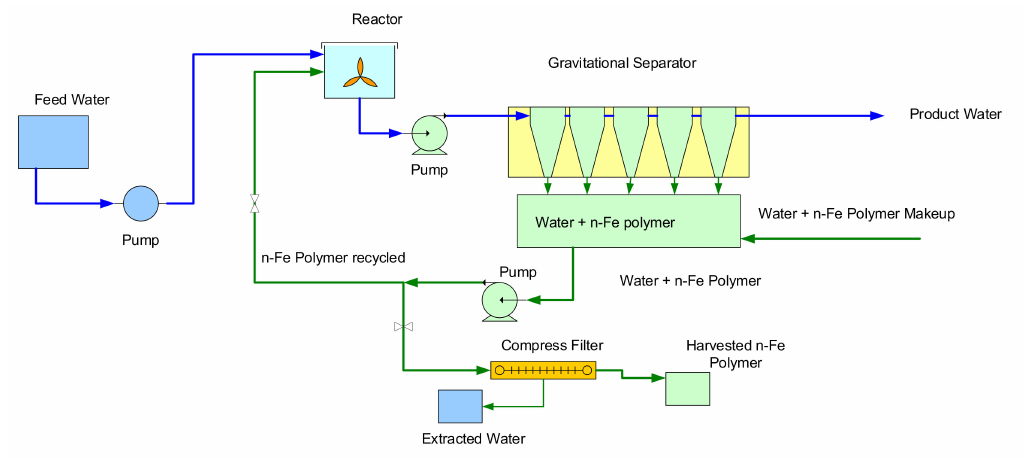
Figure 18. Process flow diagram for a desalination plant using entrained, unsupported, n-Fe-polymer